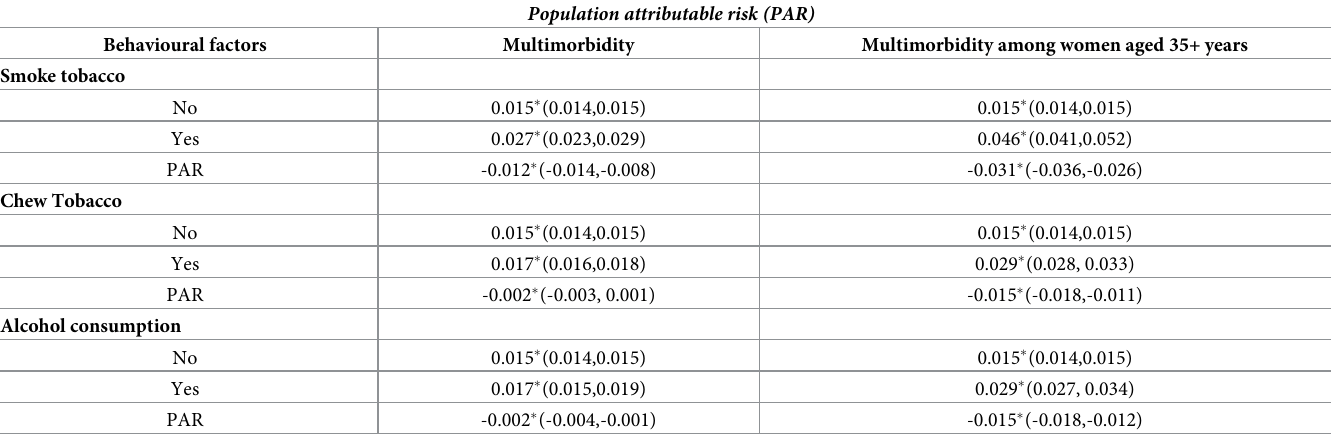
Table 4. Population attributable risk for multimorbidity among women aged 15–49 years in India,